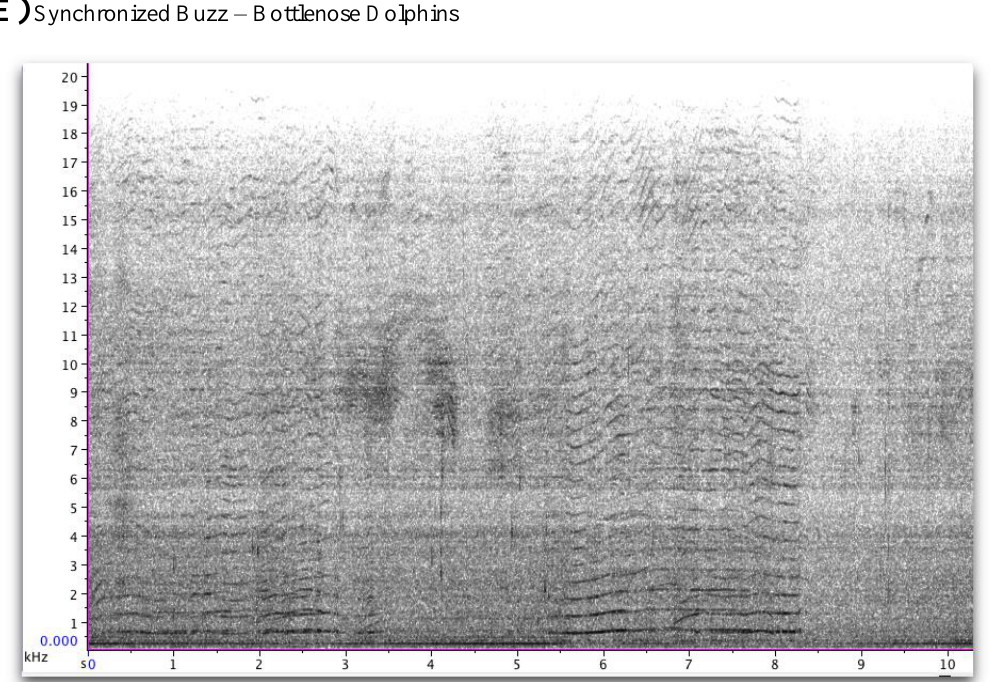
Figure 3 . Spectrographic examples of five synchronized vocalizations types. A) Synchronized Squawks of spotted Dolphins, B) Synchronized Screams of spotted dolphins, C) Frequency-modulated Whistles/Buzzes of bottlenose dolphins, D) Synchronized Brays/Buzz of bottlenose dolphins, and E) Synchronized Buzz of bottlenose